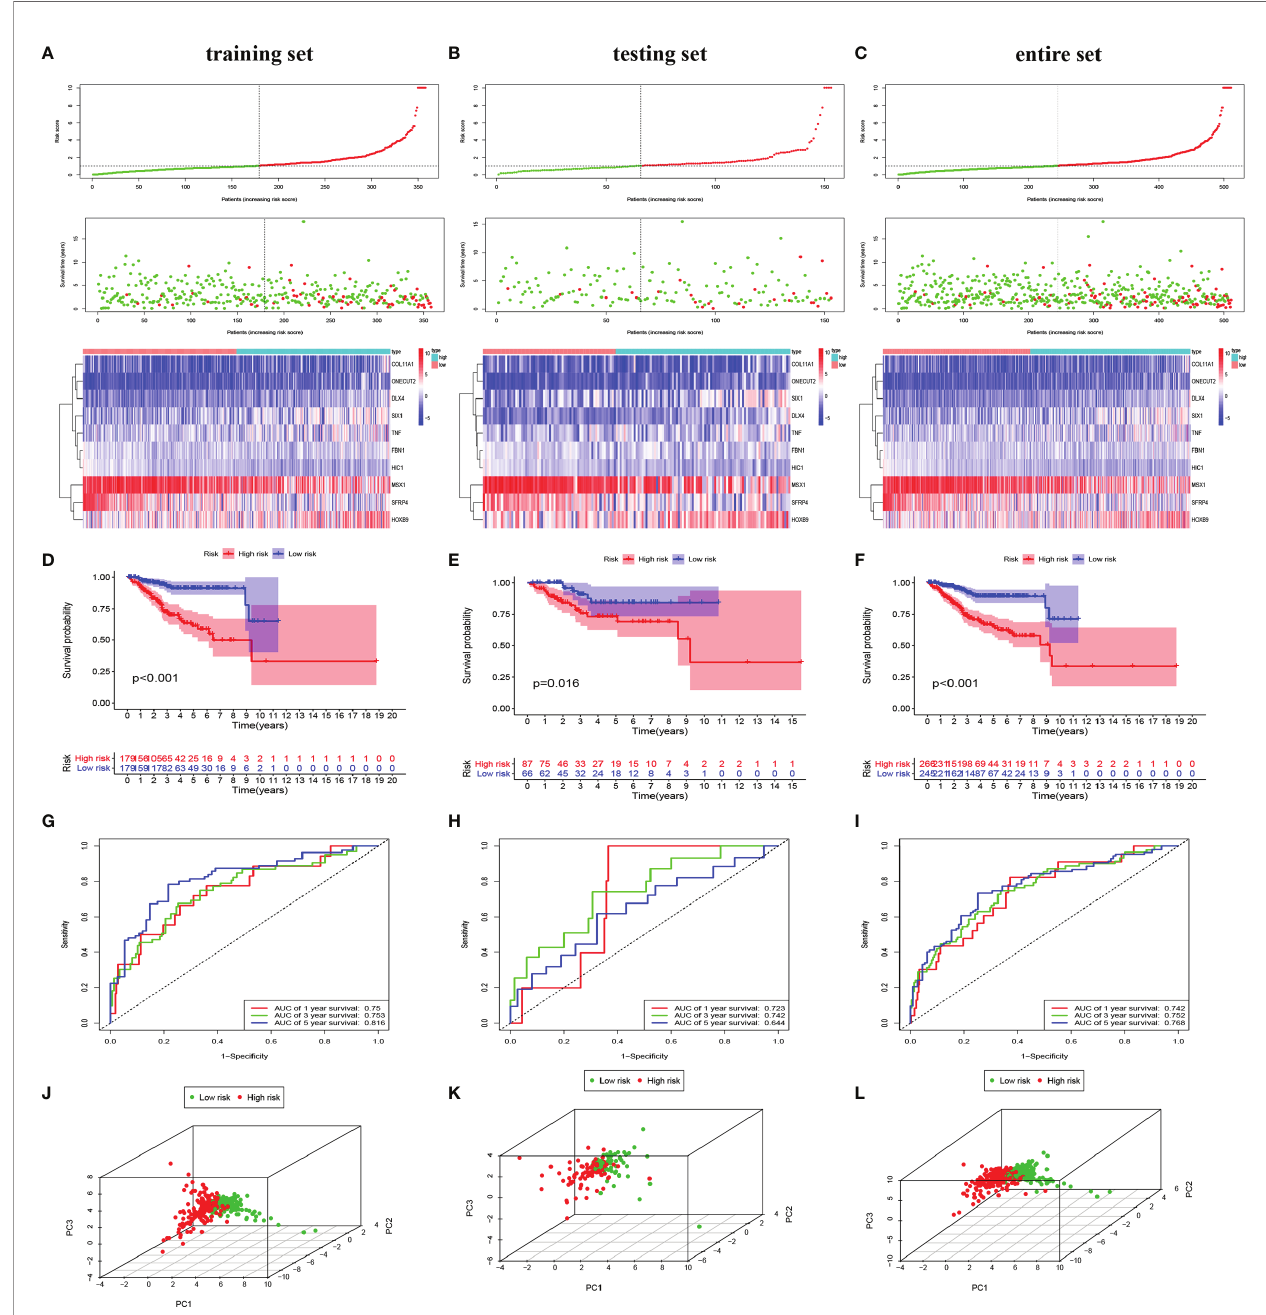
FIGURE 1 | Identi fi cation and validation of the EMT-related genes signature in the training, testing, and entire sets. The risk curve and scatter plot of each sample reordered by risk score and the heatmap showed the expression pro fi les of 10 ERGs in the low-risk group and high-risk group in the training set (A) , testing set (B) , and entire set (C) . Each square represents a clinical sample, and its color is associated with the gene expression. The higher the gene expression, the darker the color (red represents upregulated genes, and blue represents downregulated genes). Kaplan – Meier survival curves and area under the curve (AUC) value of the prognostic factors of 10 ERGs in the training set (D, G) , testing set (E, H) , and entire set (F, I) . (G) PCA reveals the difference between the high-risk and low-risk groups in the training set (J) , testing set (K) , and entire set (L) . EMT, epithelial – mesenchymal transition; ERG, EMT-related gene; PCA, principal component